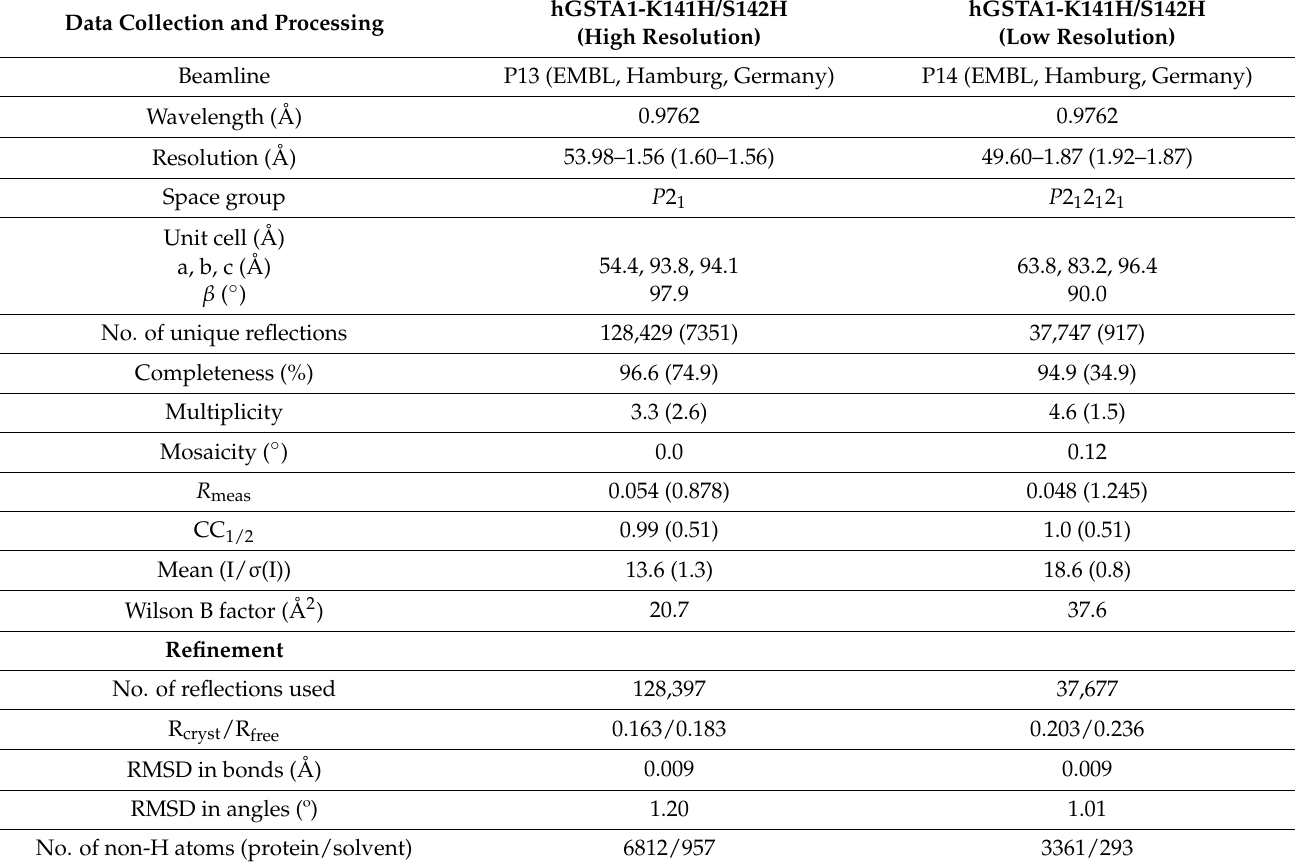
Figure 8. ( A ) Structural superposition of hGSTA1-K141H/S142H (cyan) onto hGSTA1-1 − GSH (green) (PDB code: 1PKW) [28]. GSH is shown in stick representation. ( B ) Close-up comparison of hGSTA1-K141H/S142H and hGSTA1-1 (PDB code: 1PKW) active sites after superposition. The residues that are involved in GSH binding are Tyr9, Arg15, Arg45, Glu54, Val55, Gln67, and Thr68, and Asp101 ′ and Arg131 ′ from the second subunit. The structures of hGSTA1-K141H/S142H and hGSTA1-1 − GSH are colored in cyan and green, respectively. The analysis was carried out using PyMOL Molecular Graphics System [30].